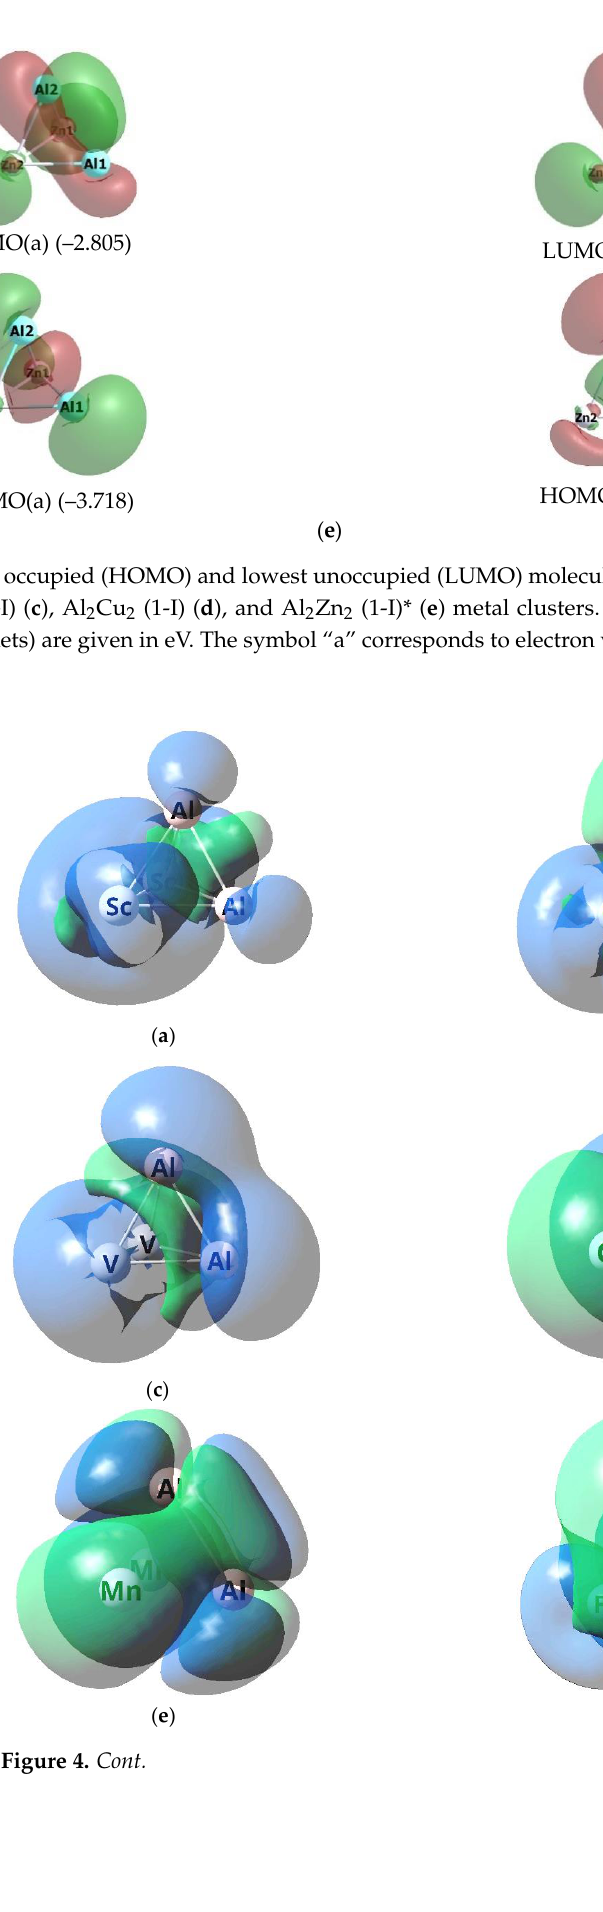
( h ) Figure 4. The pattern of distribution of the spin density in the Al 2 Sc 2 (3-I) ( a ), Al 2 Ti 2 (3-I) ( b ), Al 2 V 2 (3-I) ( c ), Al 2 Cr 2 (1-I)* ( d ), Al 2 Mn 2 (1-I)* ( e ), Al 2 Fe 2 (5-I) ( f ), Al 2 Co 2 (5-I) ( g ), and Al 2 Zn 2 (1-I)* ( h ) metal clusters. For Al 2 Ni 2 (1-I) and Al 2 Cu 2 (1-I), these pictures are absent since, for them, <S**2> = 0.